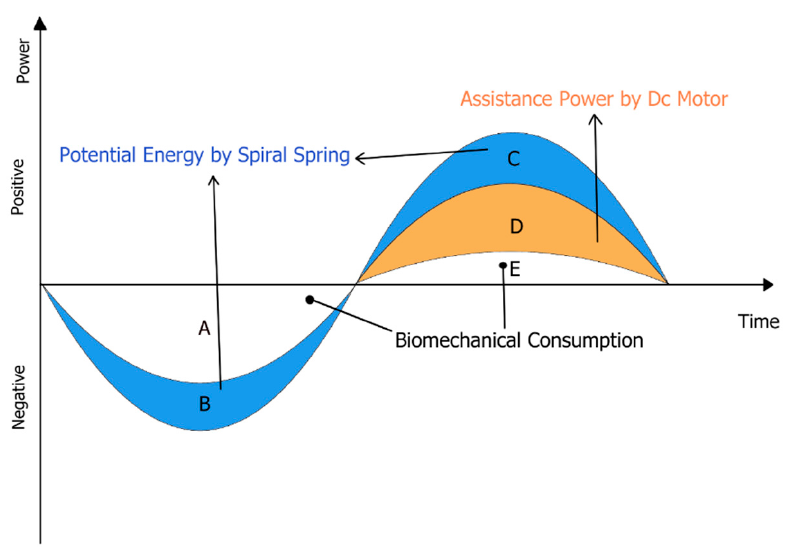
Figure 13. Theoretical description of variation in human biomechanical power using ES ‐ RSEA.